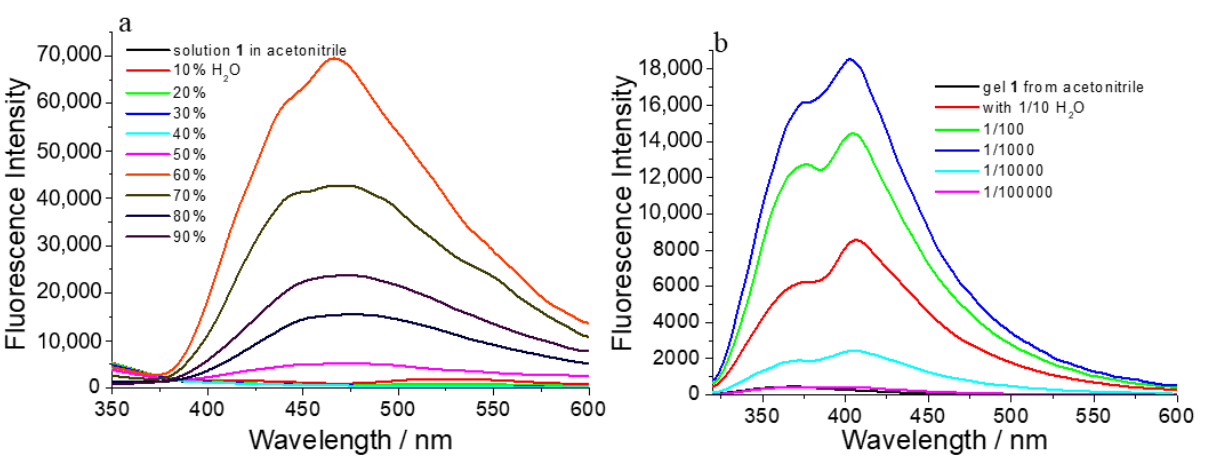
Figure 7. Fluorescence emission spectra of solution (10 − 5 M) ( a ) and gel of 1 (CGC) ( b ) in acetonitrile with different water